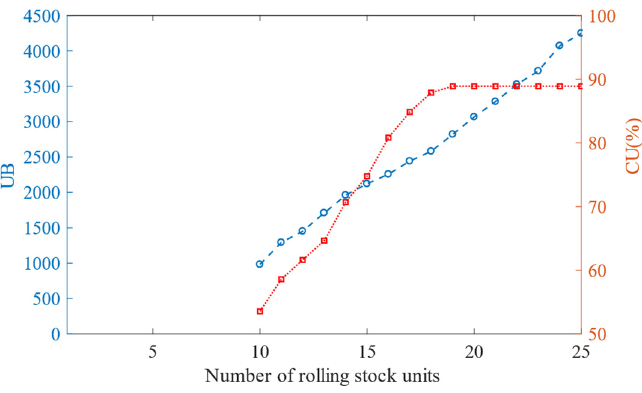
Figure 11. The variation of UB and UR with the increase in the number of rolling stock units.